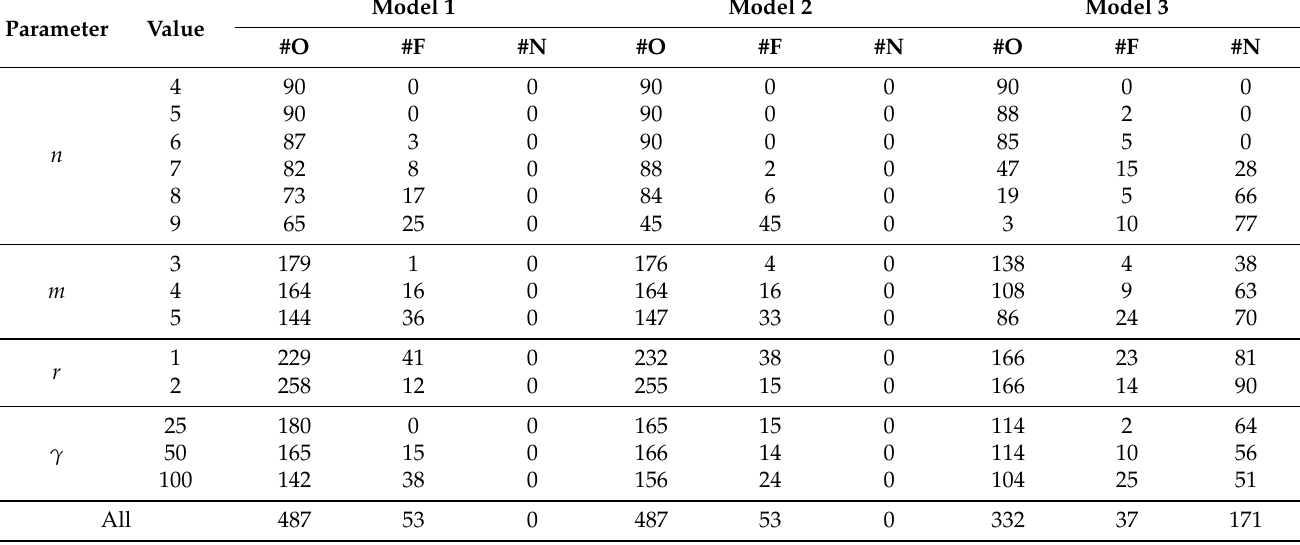
Table 3. Computational results of the proposed MILP models: optimal solutions (#O), feasible solutions (#F), and no solution is found